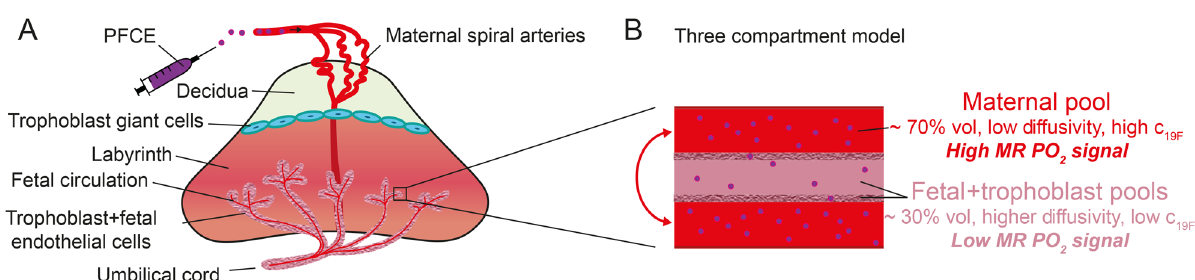
Figure 5. ( A ) Illustration of the mouse placenta and its compartments after i.v. injection of PFCE nanoemulsion. ( B ) Summarizing qualitative and quantitative arguments on volume fraction, diffusivity and 19 F concentration in a three-compartment model of the labyrinth, the maternal blood pool is the dominating source of MR PO 2